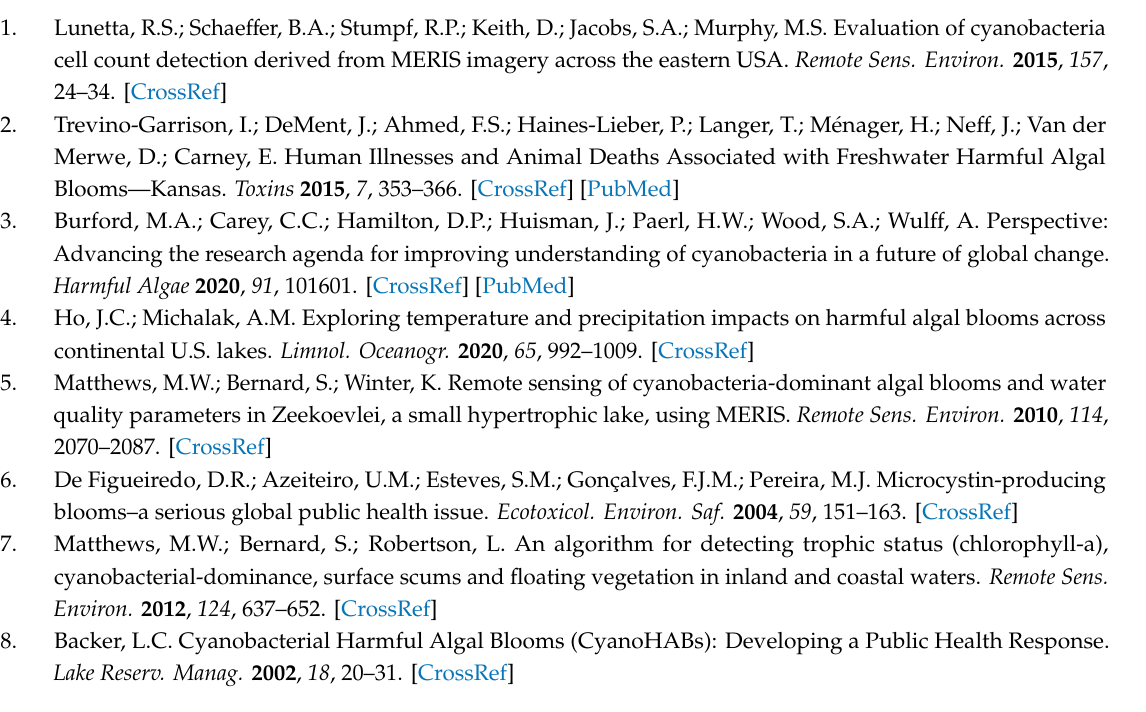
Figure S1: Python script for automatic